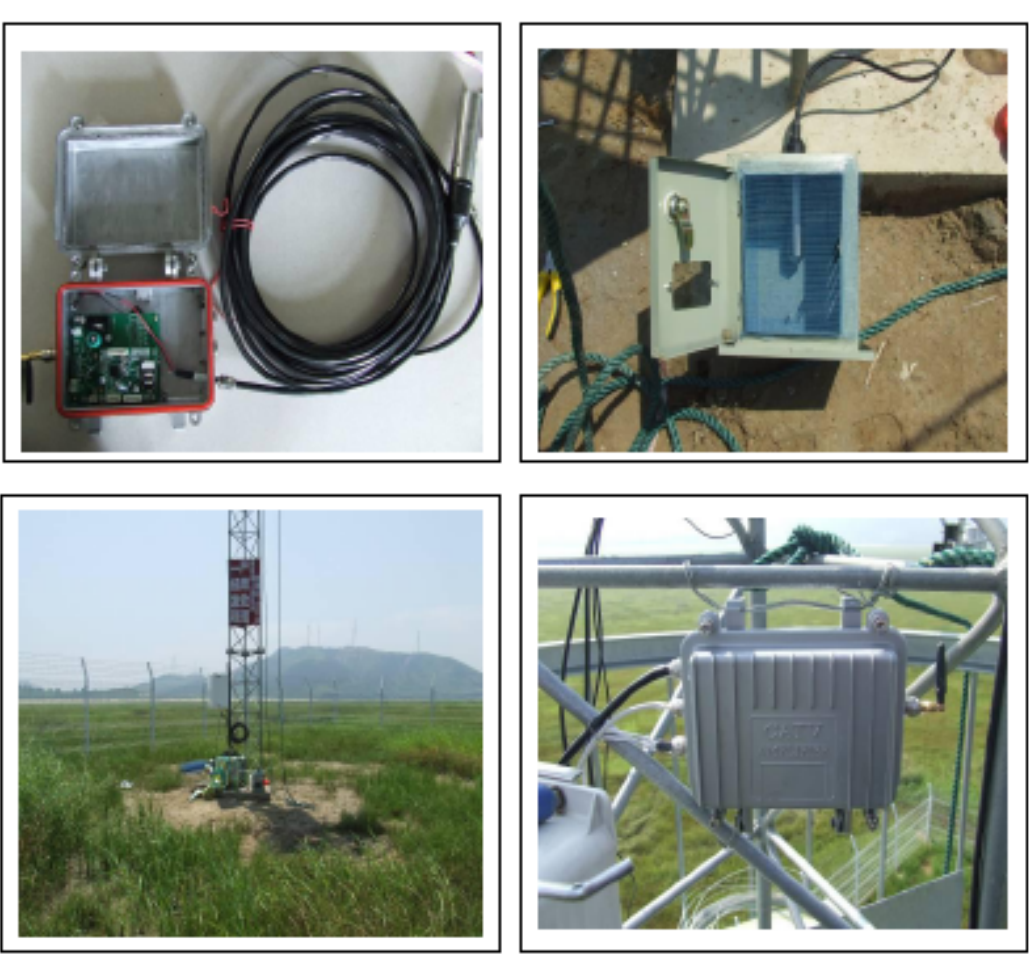
Figure 9. The installation pictures of the RWMS at Poyanghu